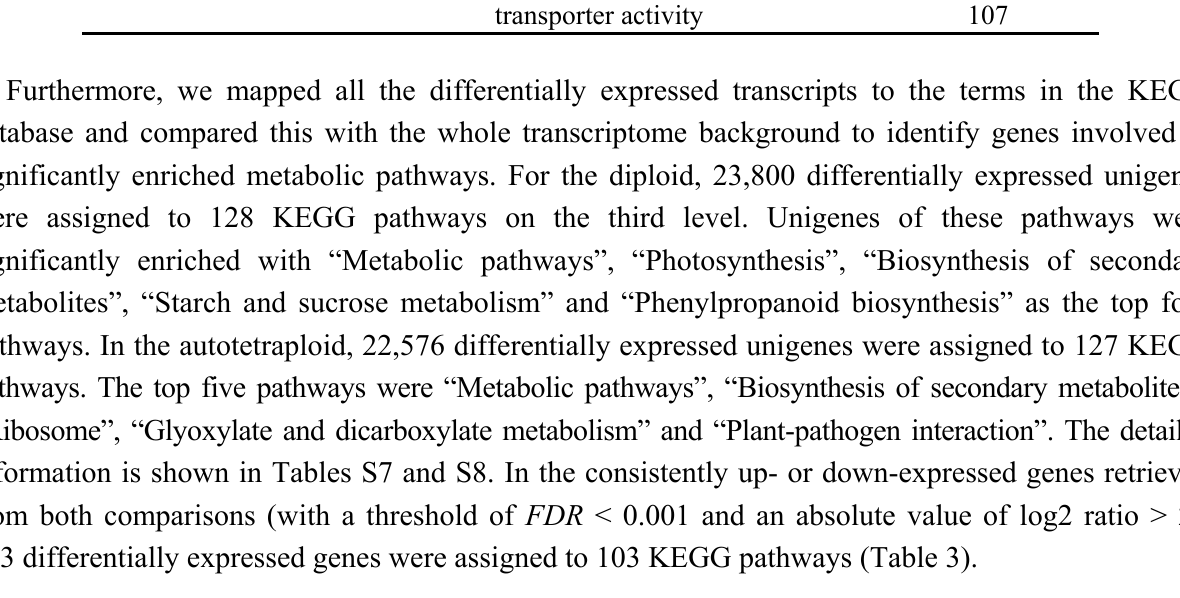
Figure 6. The statistics of differentially expressed genes in each pairwise comparison. Red bars represent the up-regulated genes, while green bars represent the down-regulated ones. PA4T, 12-day drought treated tetraploid; PA4, well-watered tetraploid. PA2T, 12-day drought treated diploid. PA2, well-watered diploid. A threshold of FDR < 0.001 and an absolute value of log2 ratio > 1 were used to judge the significance of the differences in gene